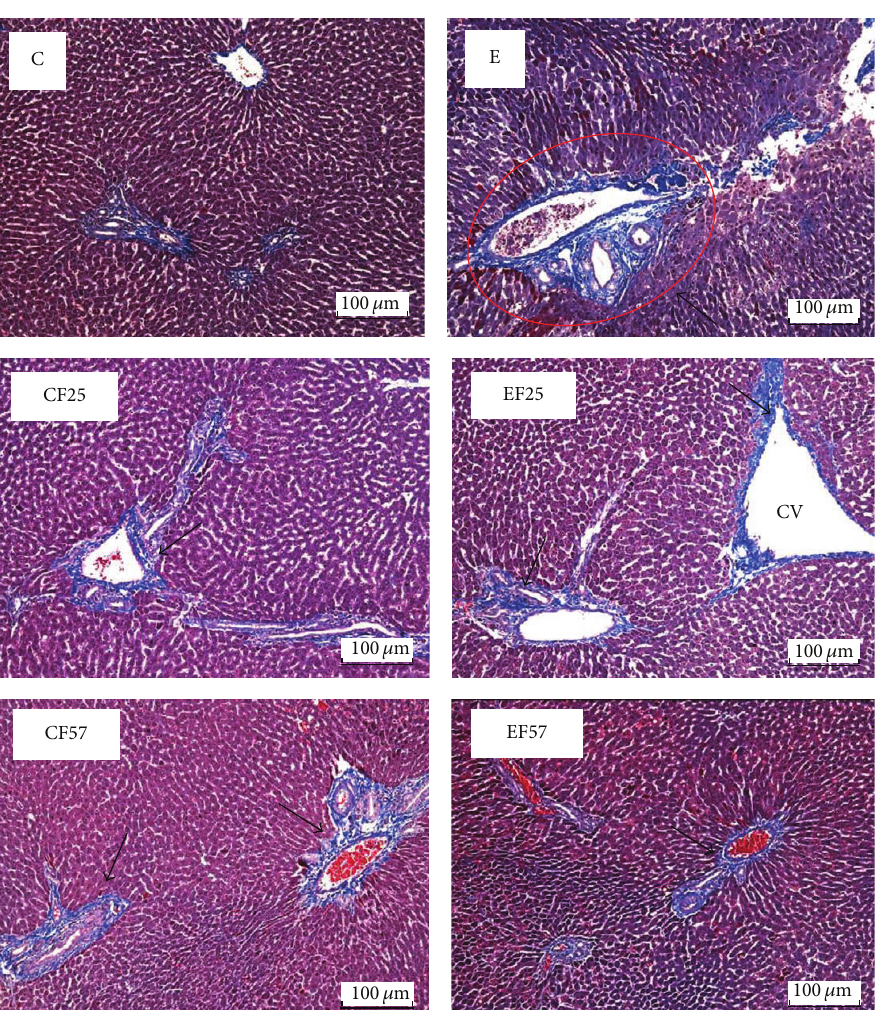
Figure 2: Representative photomicrographs of livers (Masson trichrome stain, magnification: × 200). C, control; CF25, control with 25% fish oil substituted for olive oil; CF57, control with 57% fish oil substituted for olive oil; E, ethanol; EF25, ethanol with 25% fish oil substituted for olive oil; EF57, ethanol with 57% fish oil substituted for olive oil. CV, central vein. Collagenous fibers (arrows) were stained in several biopsy specimens of E group; however, few collagenous fibers were found in the other groups.